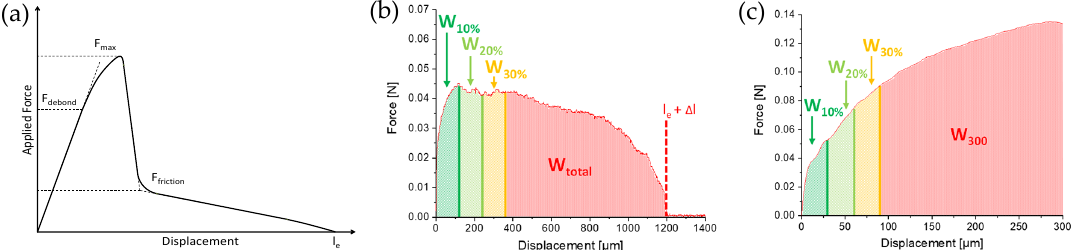
Figure 7. Force–displacement curves in the single-fiber pull-out tests on PP fibers: ( a ) typical curve showing debonding initiation, complete debonding, and frictional pull-out; typical curves were generated in ( b ) quasi-static and ( c ) dynamic tests.